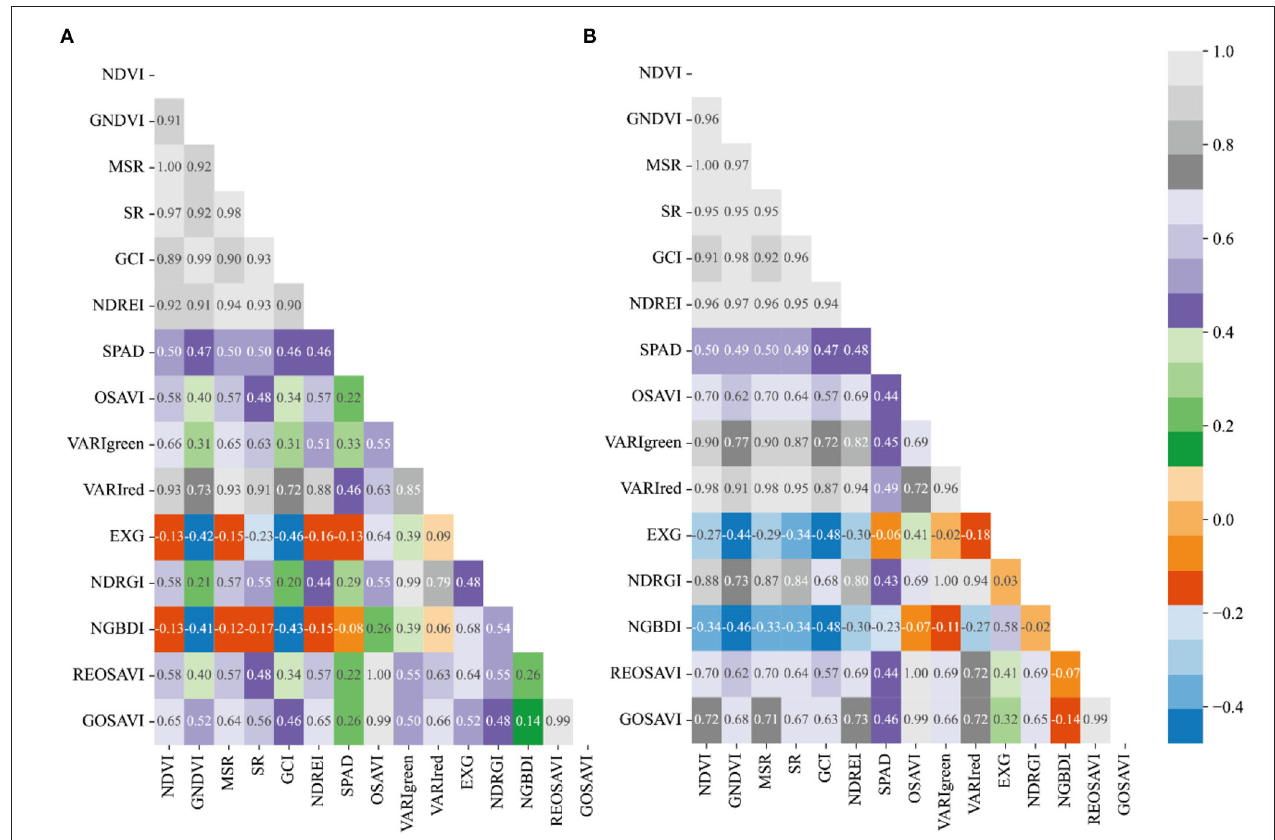
FIGURE 7 | Plot of correlation between different vegetation indices and CC of winter wheat during flowering stage: (A) Normal treatment of Manas winter wheat during flowering stage, and (B) water limited treatment of Manas winter wheat during flowering stage. All vegetation indices that appear in the figure are explained in Table 3